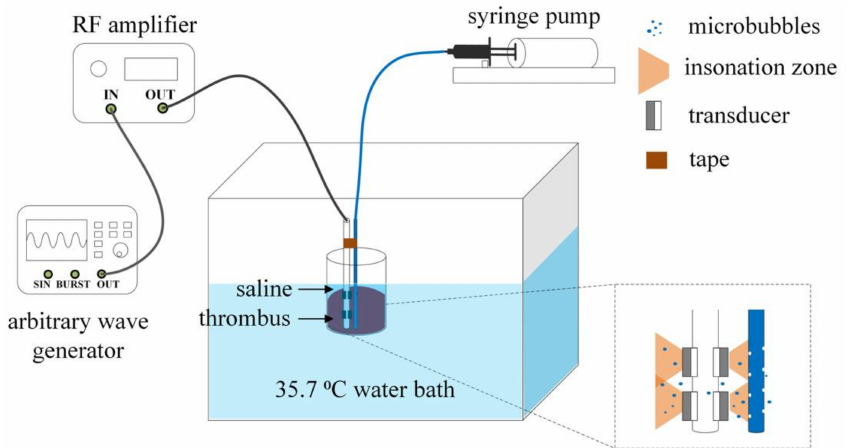
Figure 4. Schematic of thrombolysis experimental